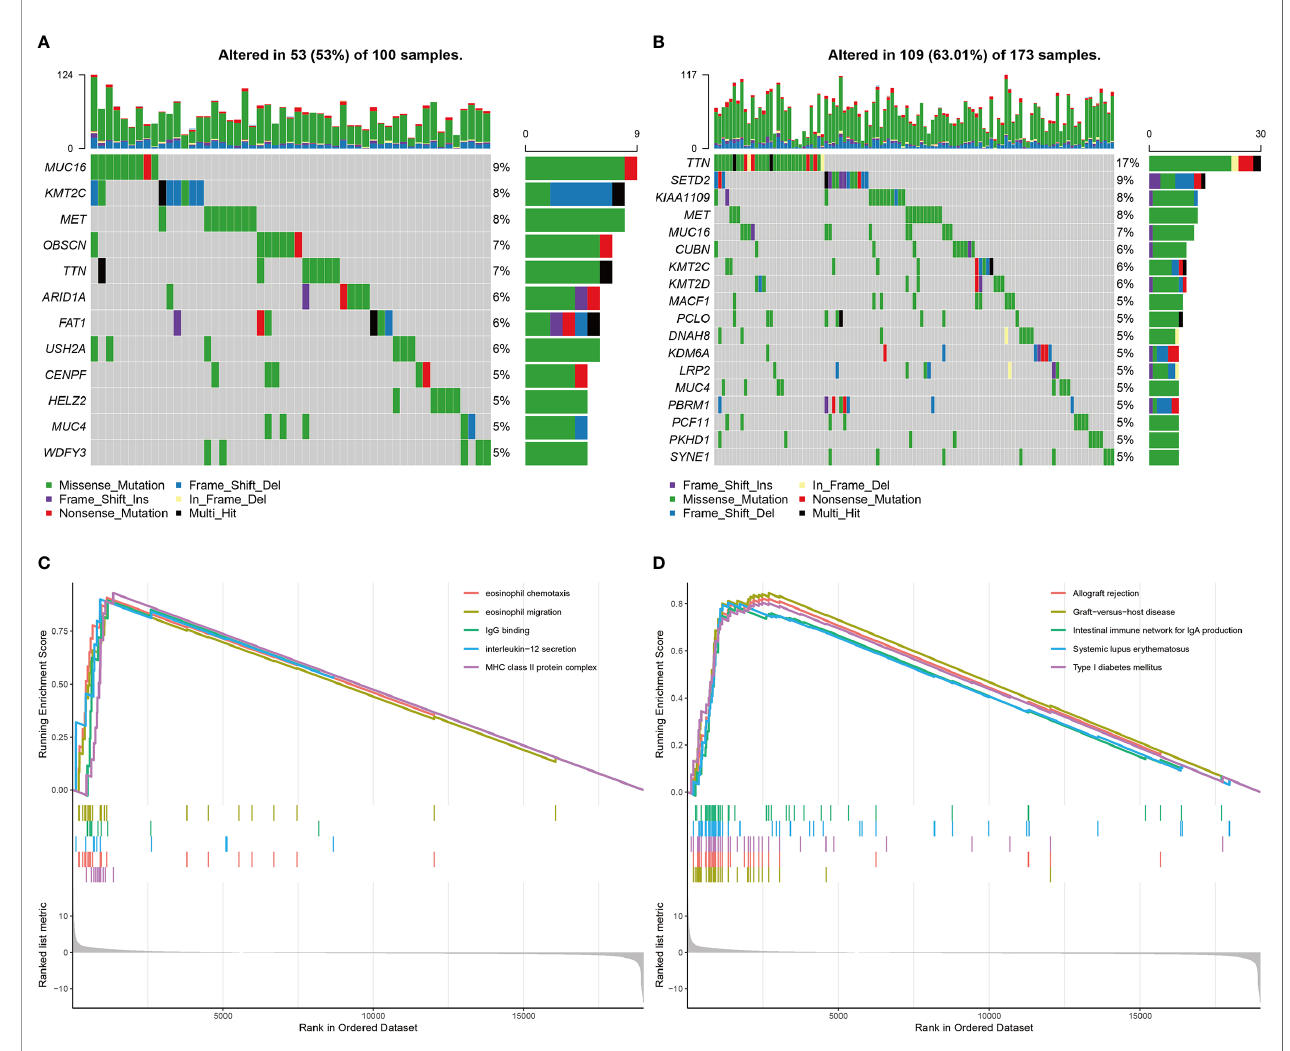
FIGURE 11 | Landscapes of mutant genes in immunotherapy response groups and GSEA results. (A) The waterfall plot of genes with mutation frequency greater than 5% in the high immunotherapy response group. (B) The waterfall plot of genes with mutation frequency greater than 5% in the low/medium immunotherapy response group. (C) GO enrichments of GSEA between the high response group and low/medium group. (D) KEGG enrichments of GSEA between the high response group and low/medium